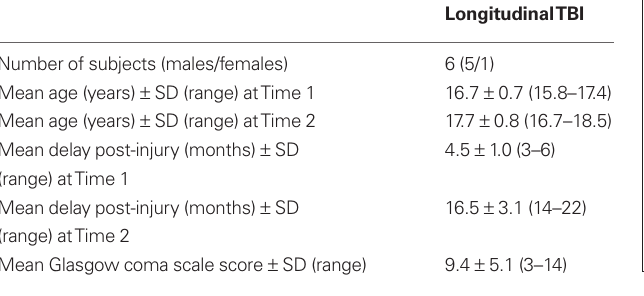
Table 2 | Description of TBI group for the longitudinal study.